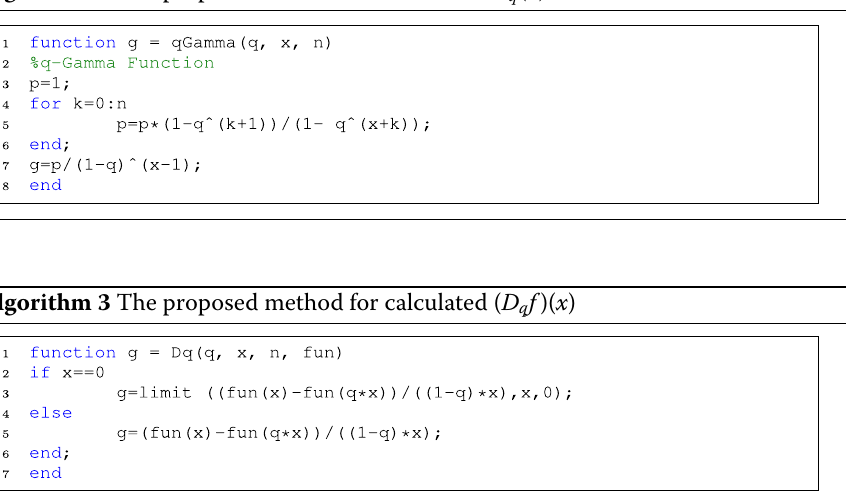
Algorithm 2 The proposed method for calculated Γ q ( x )